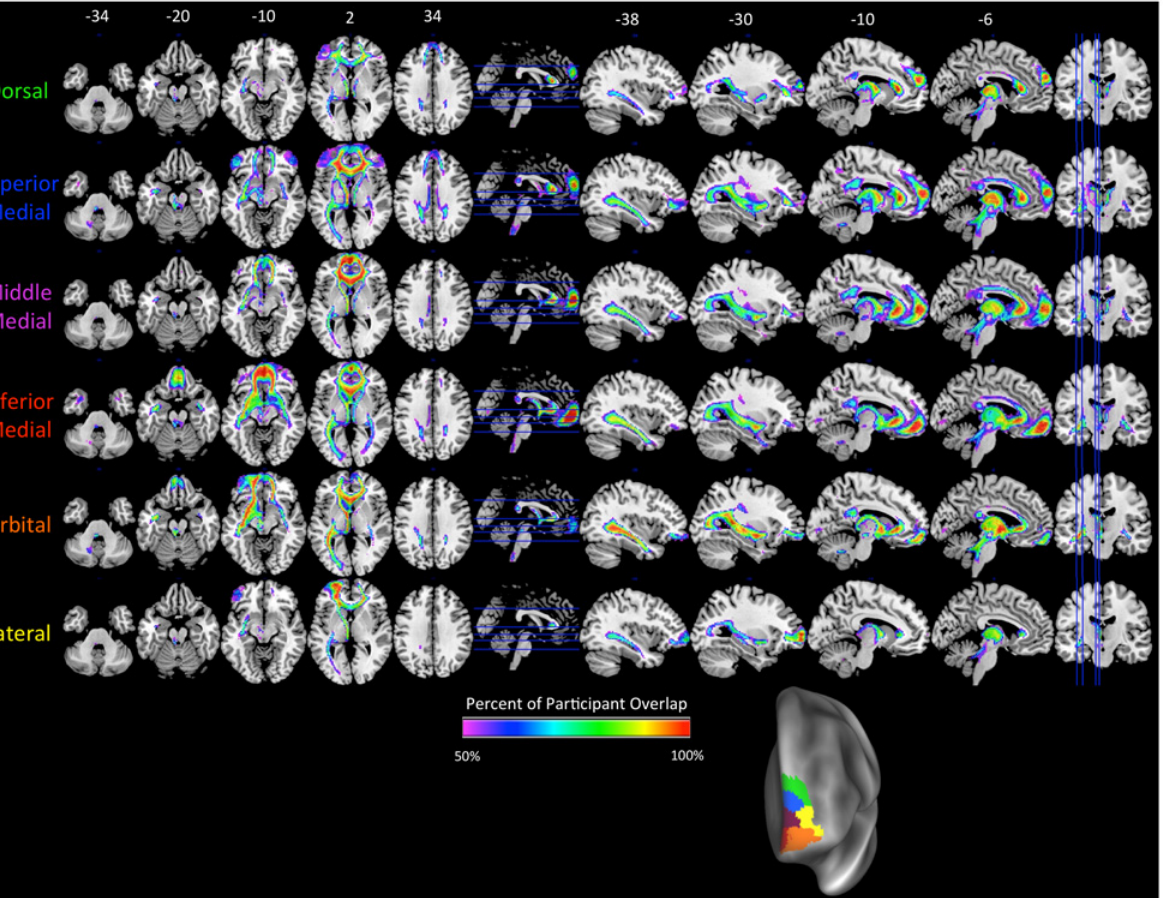
Fig 3. Tracts originating from each of the clusters in the left hemisphere K = 6. Label colors (on left) match the cluster colors in Fig 2 (K = 6), which is reproduced at the bottom right. The color scale on brain maps represents the proportion of tract overlap across the participants, with the maps thresholded at 50%. Axial slices are shown in the left column, with slice locations marked on the sagittal slice with a blue line. Sagittal slices are shown in the right column, with slice locations marked on the axial slice with a blue line. MNI coordinates for the z -axis (axial slices) and x -axis (sagittal slices) are shown above the top